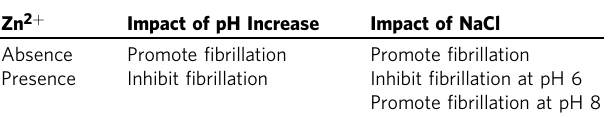
Table 2 Interplay between ionic strength, pH, and Zn 2 + for A β fi